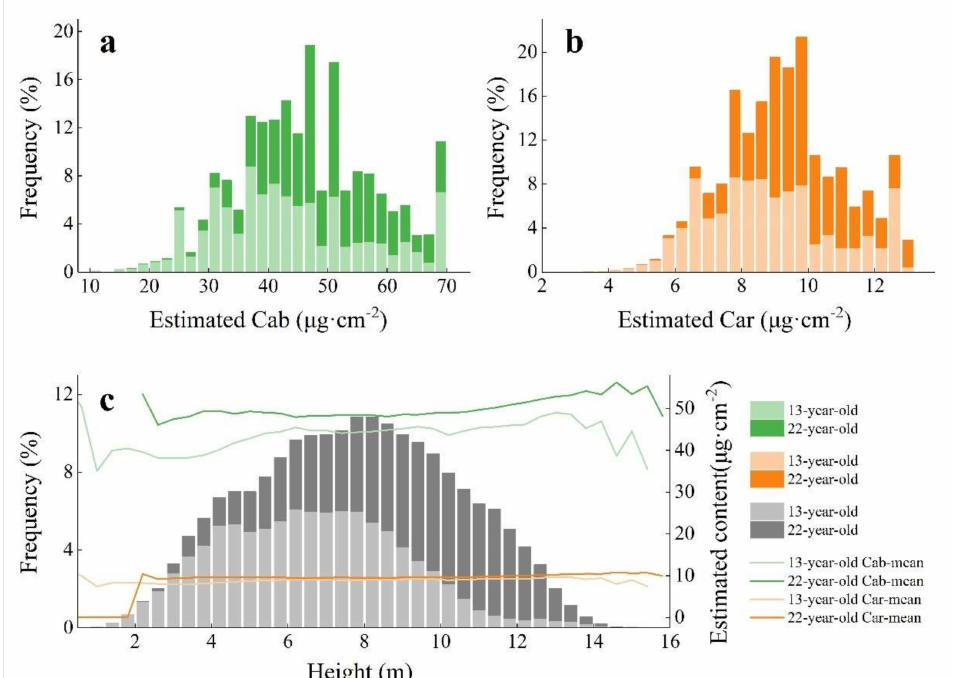
Figure 9. Stacked histogram of the estimated distribution of biochemical pigments at different ages. ( a ): stacking diagram of frequencies for the estimated Cab content; ( b ) stacking diagram of frequencies for the estimated Car content; ( c ): stacking diagram of frequencies for the tree height and the mean distribution of pigments. Note: Cab = total chlorophyll content ( µ g · cm − 2 ); Car = total carotenoids content ( µ g · cm − 2